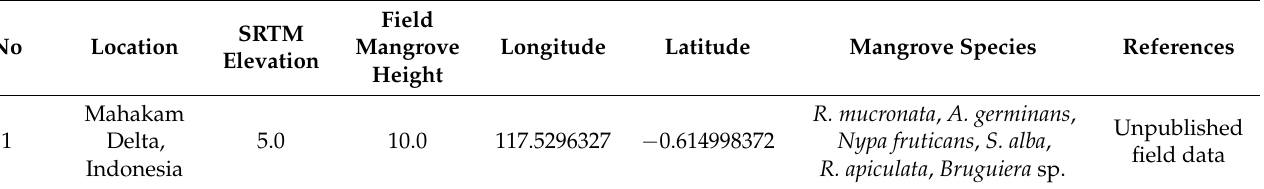
Figure 1. Relationship between mangrove canopy height from SRTM elevation and globally distributed field-based data. Field data sites are shown as red dots on the world map ( A ). A linear relationship was derived between the field-based height data and SRTM elevation data ( B ). Table 1. Locations and mangrove species that were represented in the field data set that was used to produce the ‘height vs. SRTM model’ in this study.